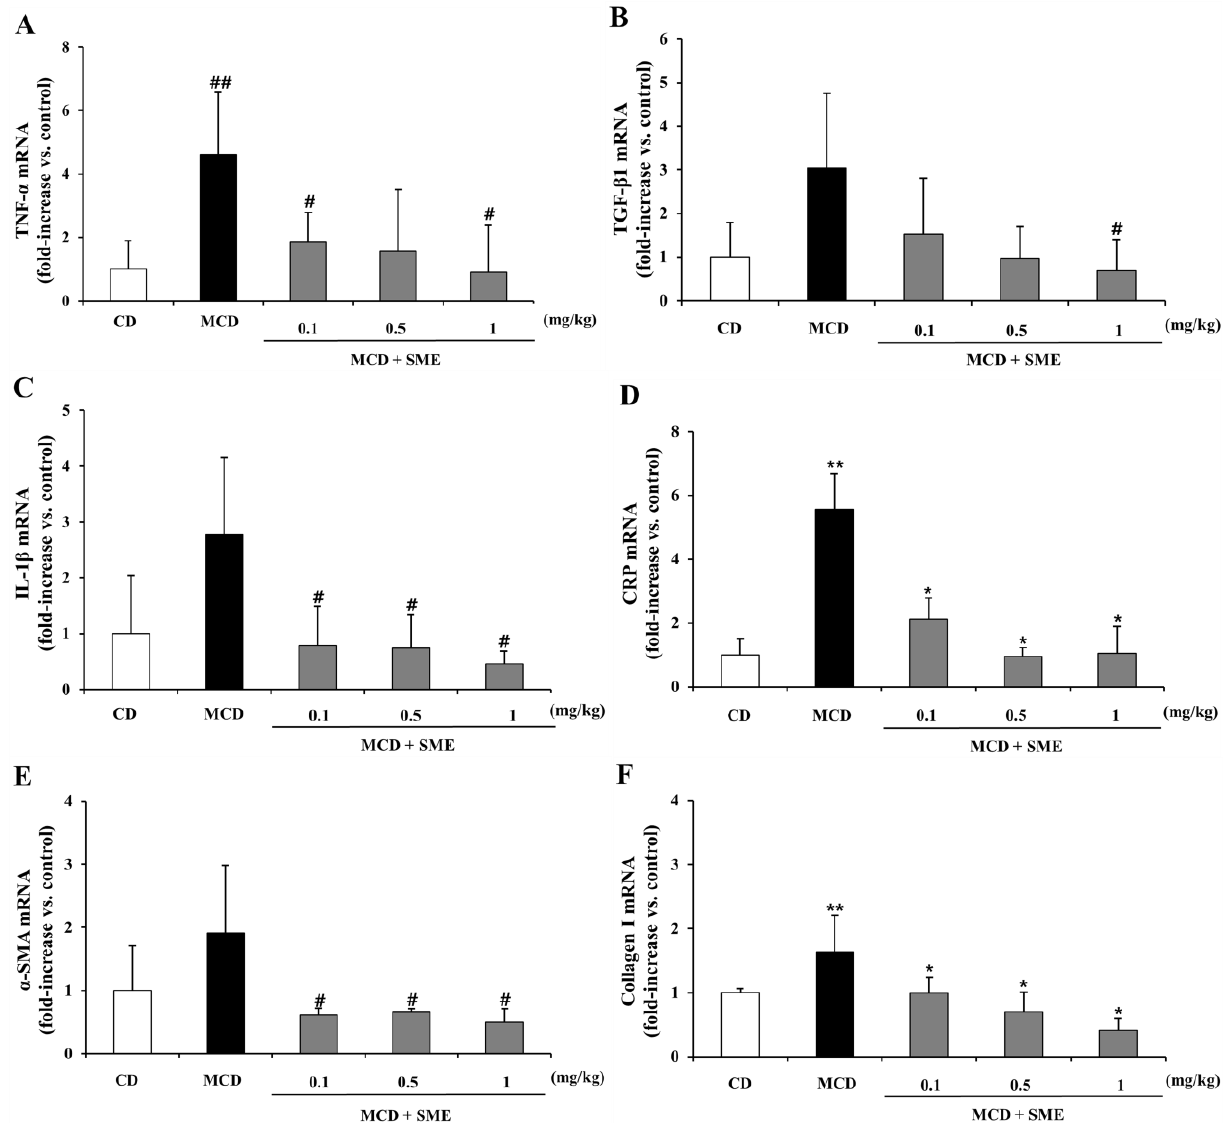
Figure 6. Effect of SME on hepatic mRNA expression of NASH-related specific genes in the livers of mice fed the MCD diet. Comparison of mice fed with MCD diet only for 12 weeks (control) and treated with SME or vehicle by oral gavage from week 9 to 12. ( A